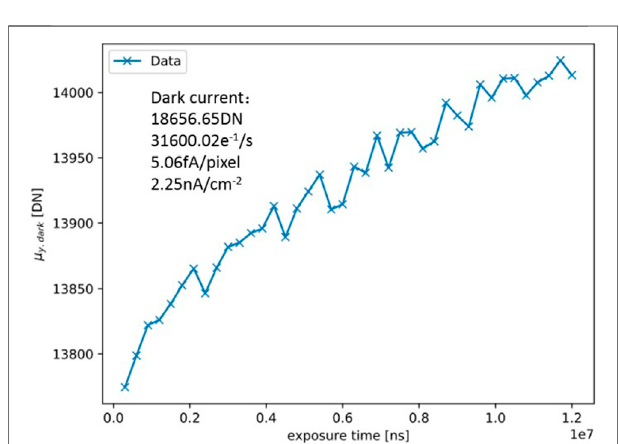
FIGURE 6 | The dark value versus exposure time.